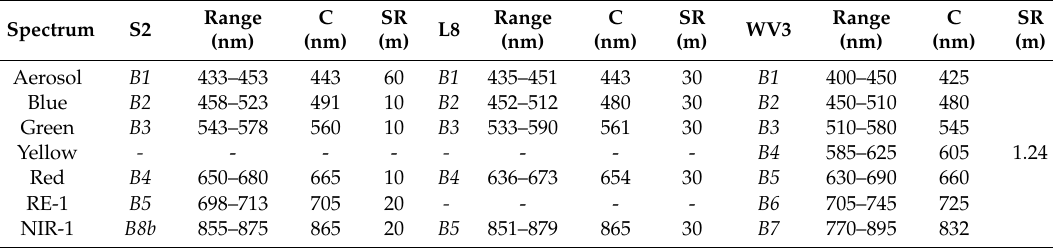
Table 1. Sensor band configurations used in this study.